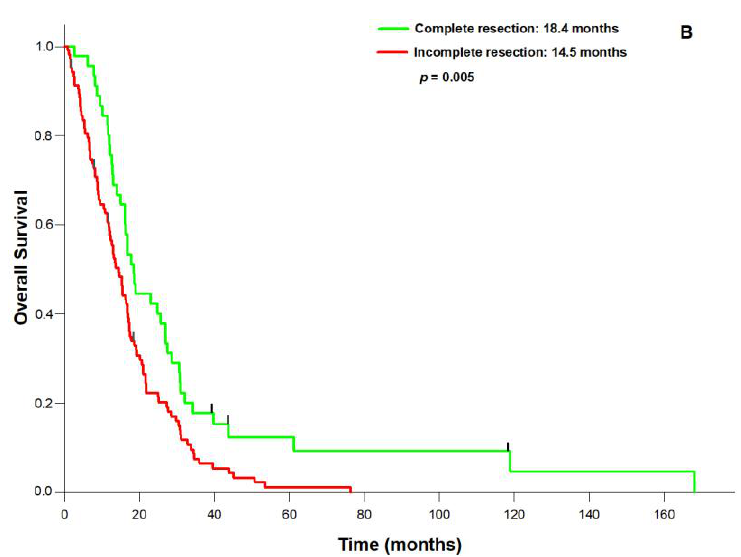
Figure 1. Resection status and outcome in patients with newly diagnosed GBM: ( A ): Progression-free survival is significantly longer after 100% resection than after <100% resection; ( B ): Complete resection also leads to significant overall survival benefit.